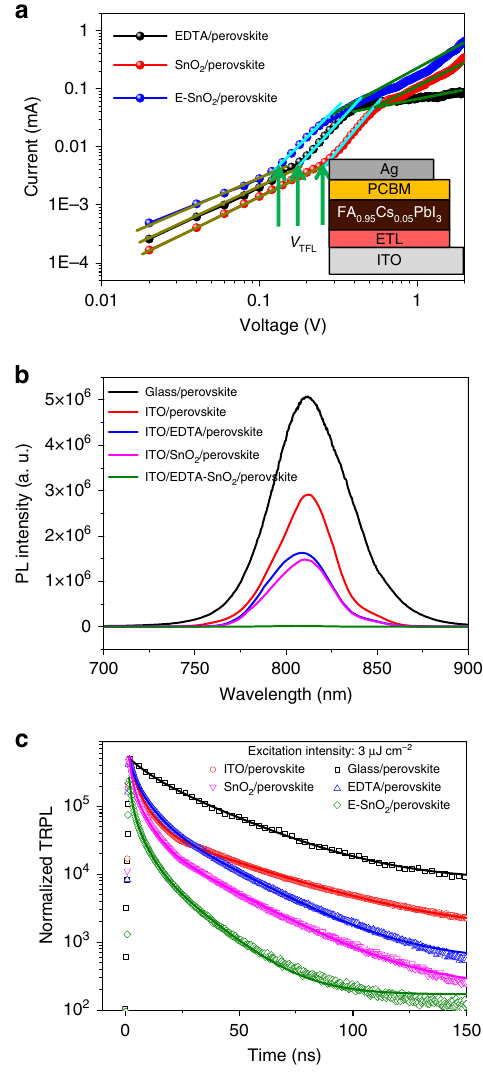
Fig. 3 The charge transfer between perovskite and different ETLs. a Dark I – V curves of the electron-only devices with the V TFL kink points. The inset shows the structure of the electron-only device. b Steady-state PL and